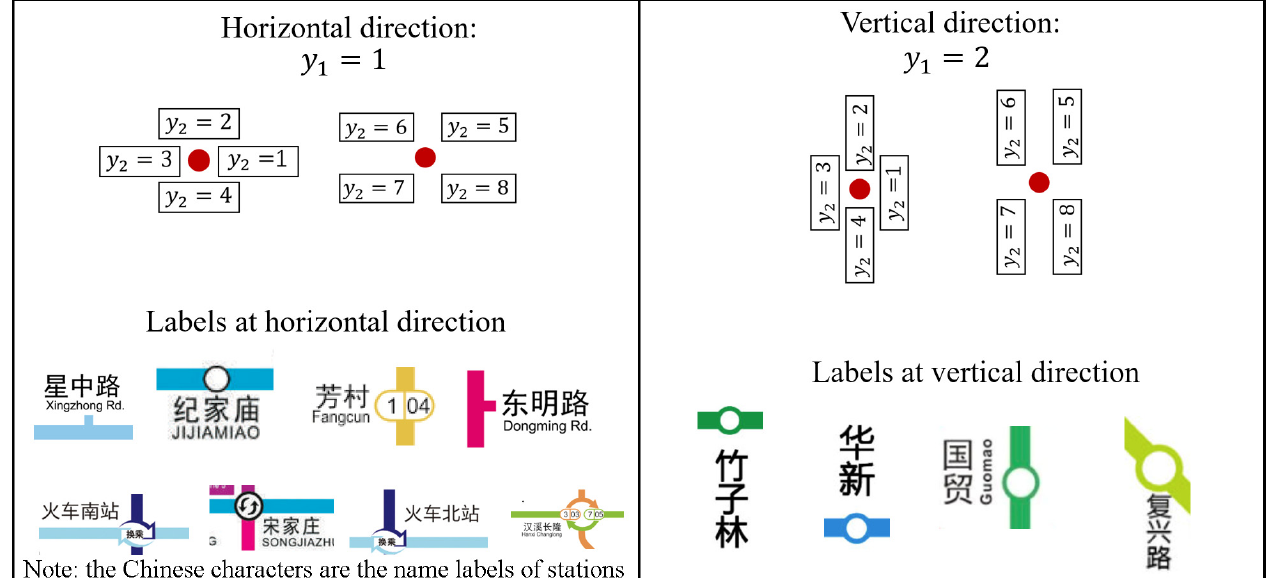
Figure 8. Different positions and directions for name labels.